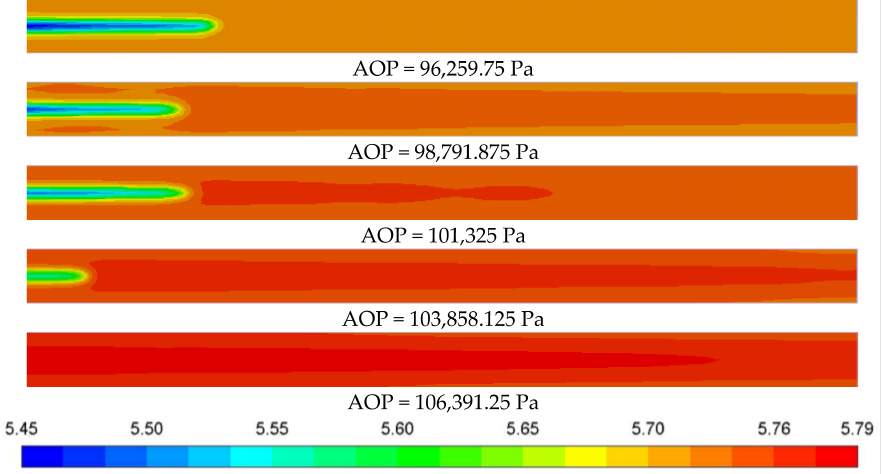
Figure 14. Water content distribution under the fluctuation of